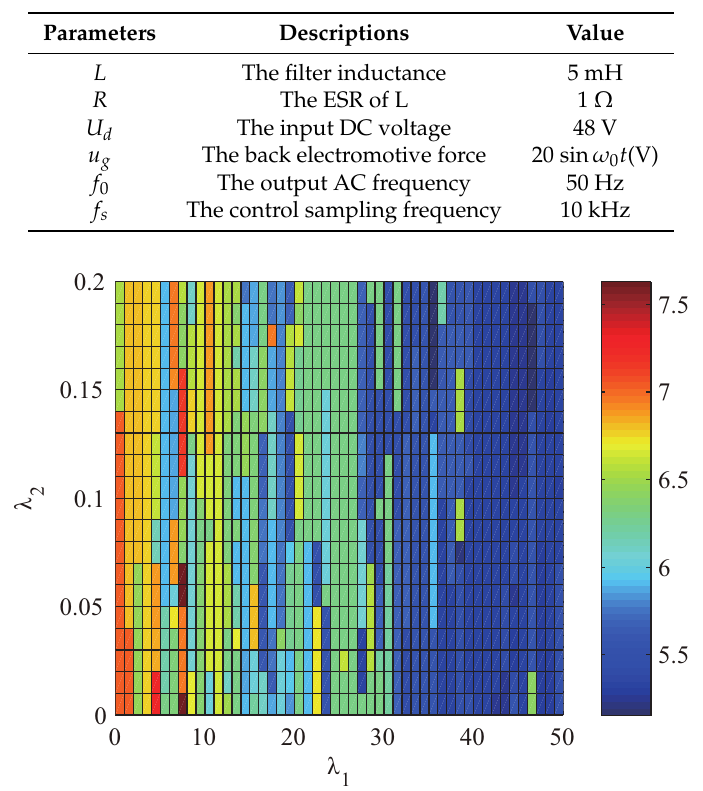
Figure 6. THD performance of different